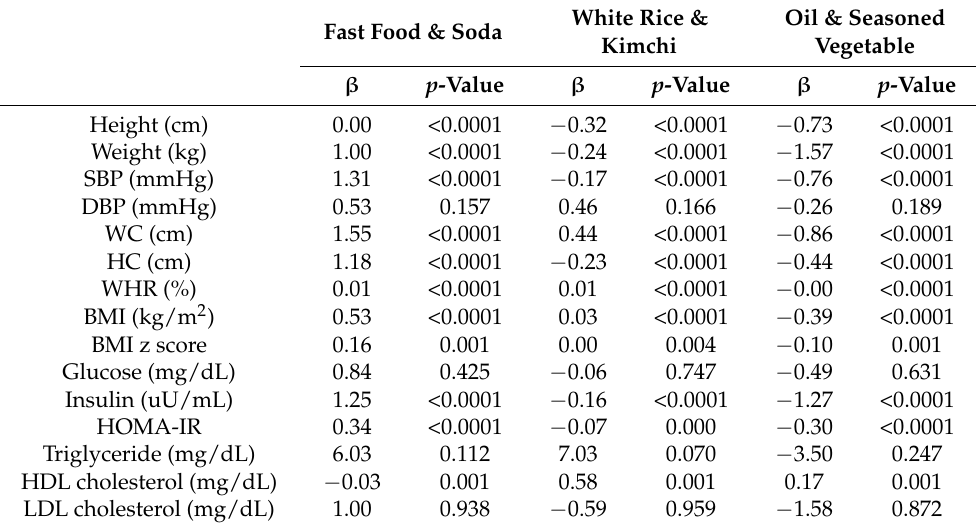
Table 4. Associations between dietary patterns and metabolic risk factors in Korean children and adolescents.